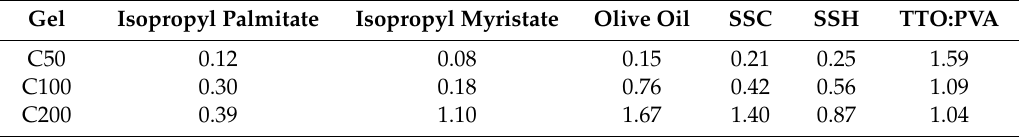
Table 2. Swelling ratios ( w / w ) of carbohydrate based organogels after 24 h in di ff erent organic